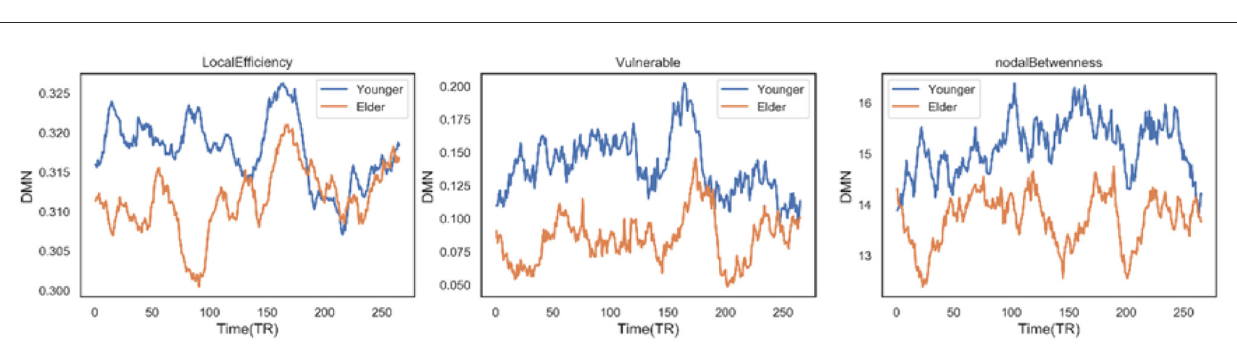
FIGURE7 Time varying curve of the three dynamic measures of DMN network: local efficiency, vulnerable, nodal betweenness in age-different group, where no matter which metric elder people are